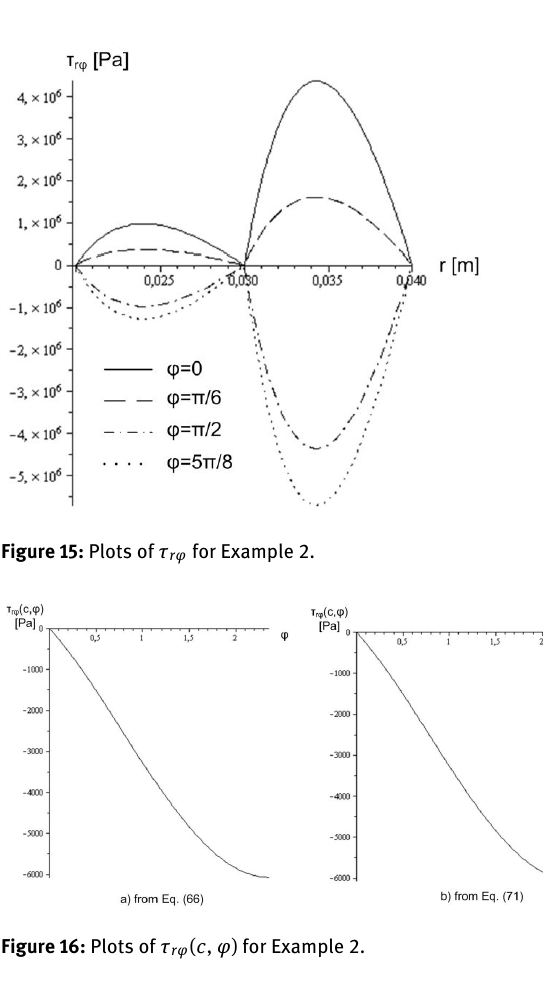
Figure 16: Plots of τ rφ ( c , φ ) for Example 2.